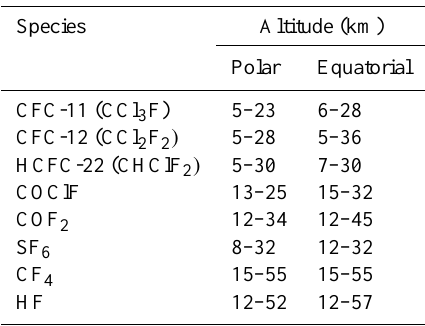
Table 2. The retrieval altitudes of the fluorine-containing species used in this